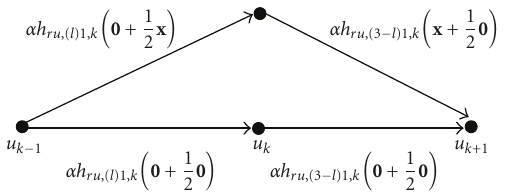
Figure 5: Trellis code for RA-Precoded scheme between symbols 0 and x